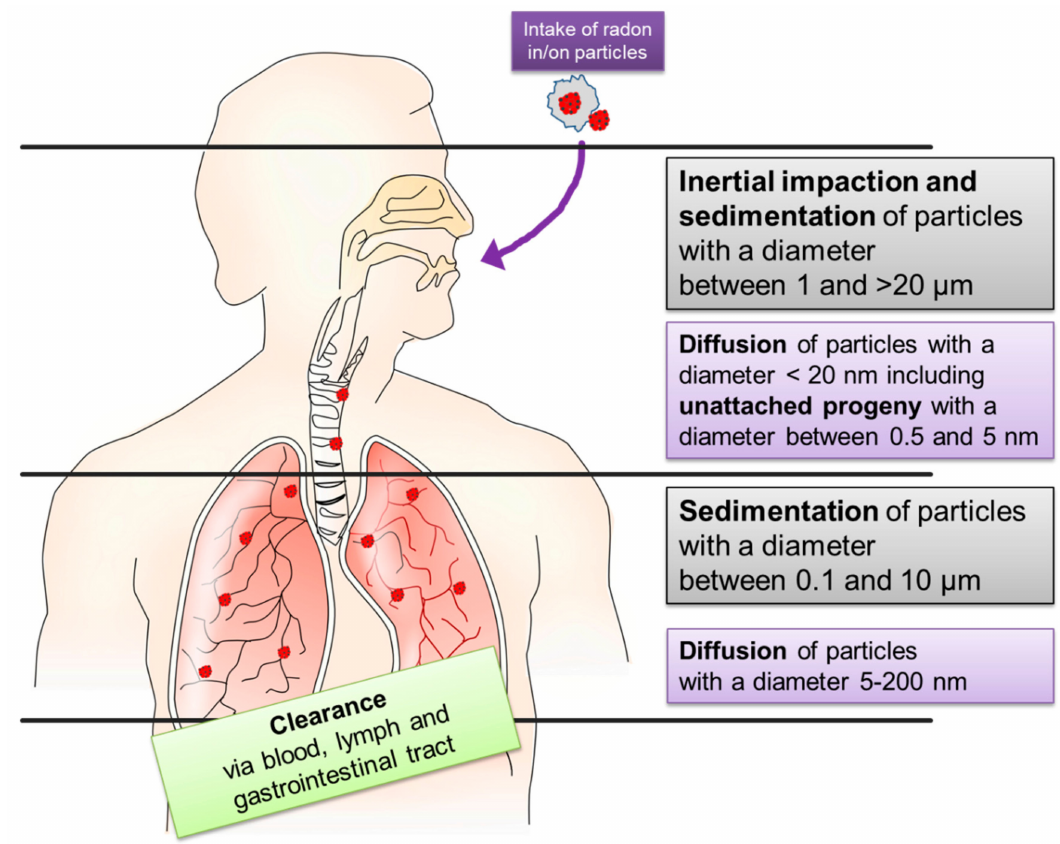
Figure 1. Different deposition mechanism for attached and unattached particles with various particle sizes. Drawing was taken from OpenClipart-Vectors on Pixabay under Creative